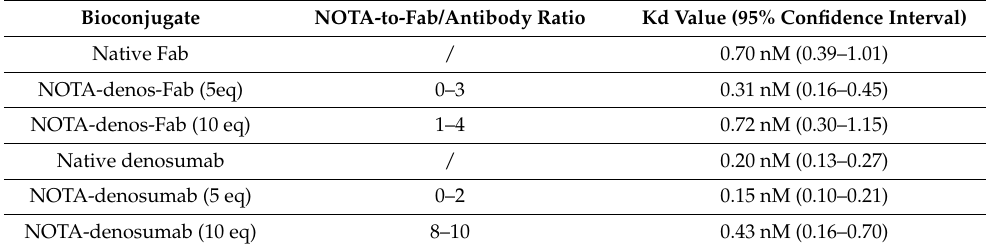
Table 1. Bioconjugates loading efficiency and Kd determination.